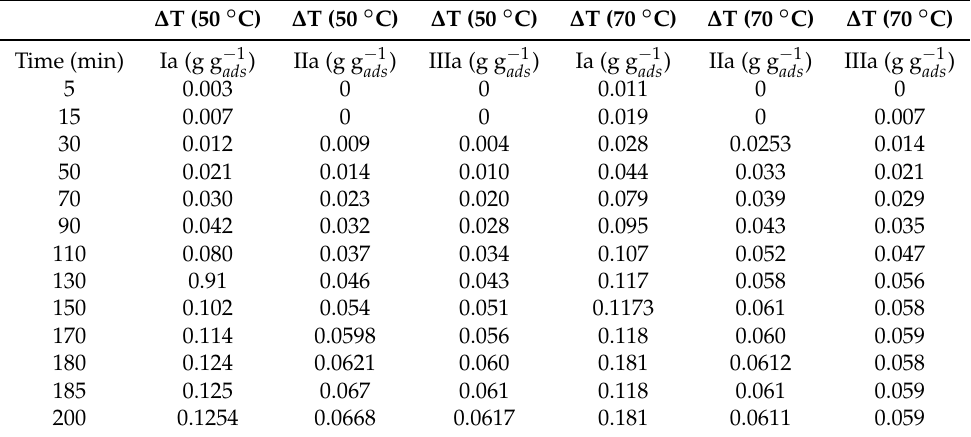
Table 3. Adsorption of samples at different time ( C 2 H 5 OH kinetic